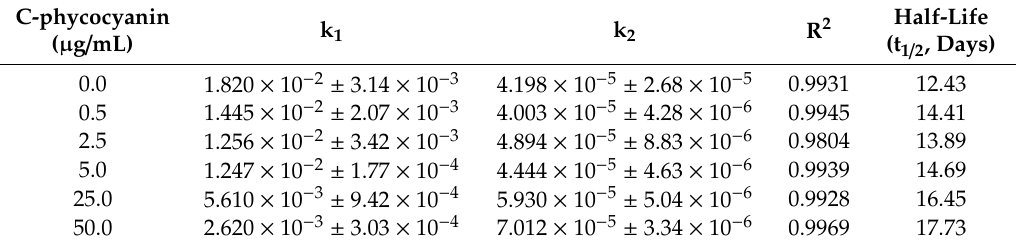
Table 1. Kinetic fitting result of amyloid formation.